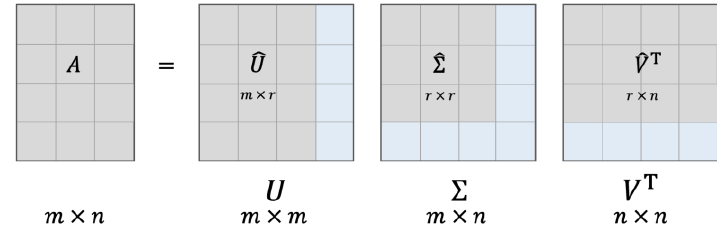
Figure 5. Schematic representation of an SVD.